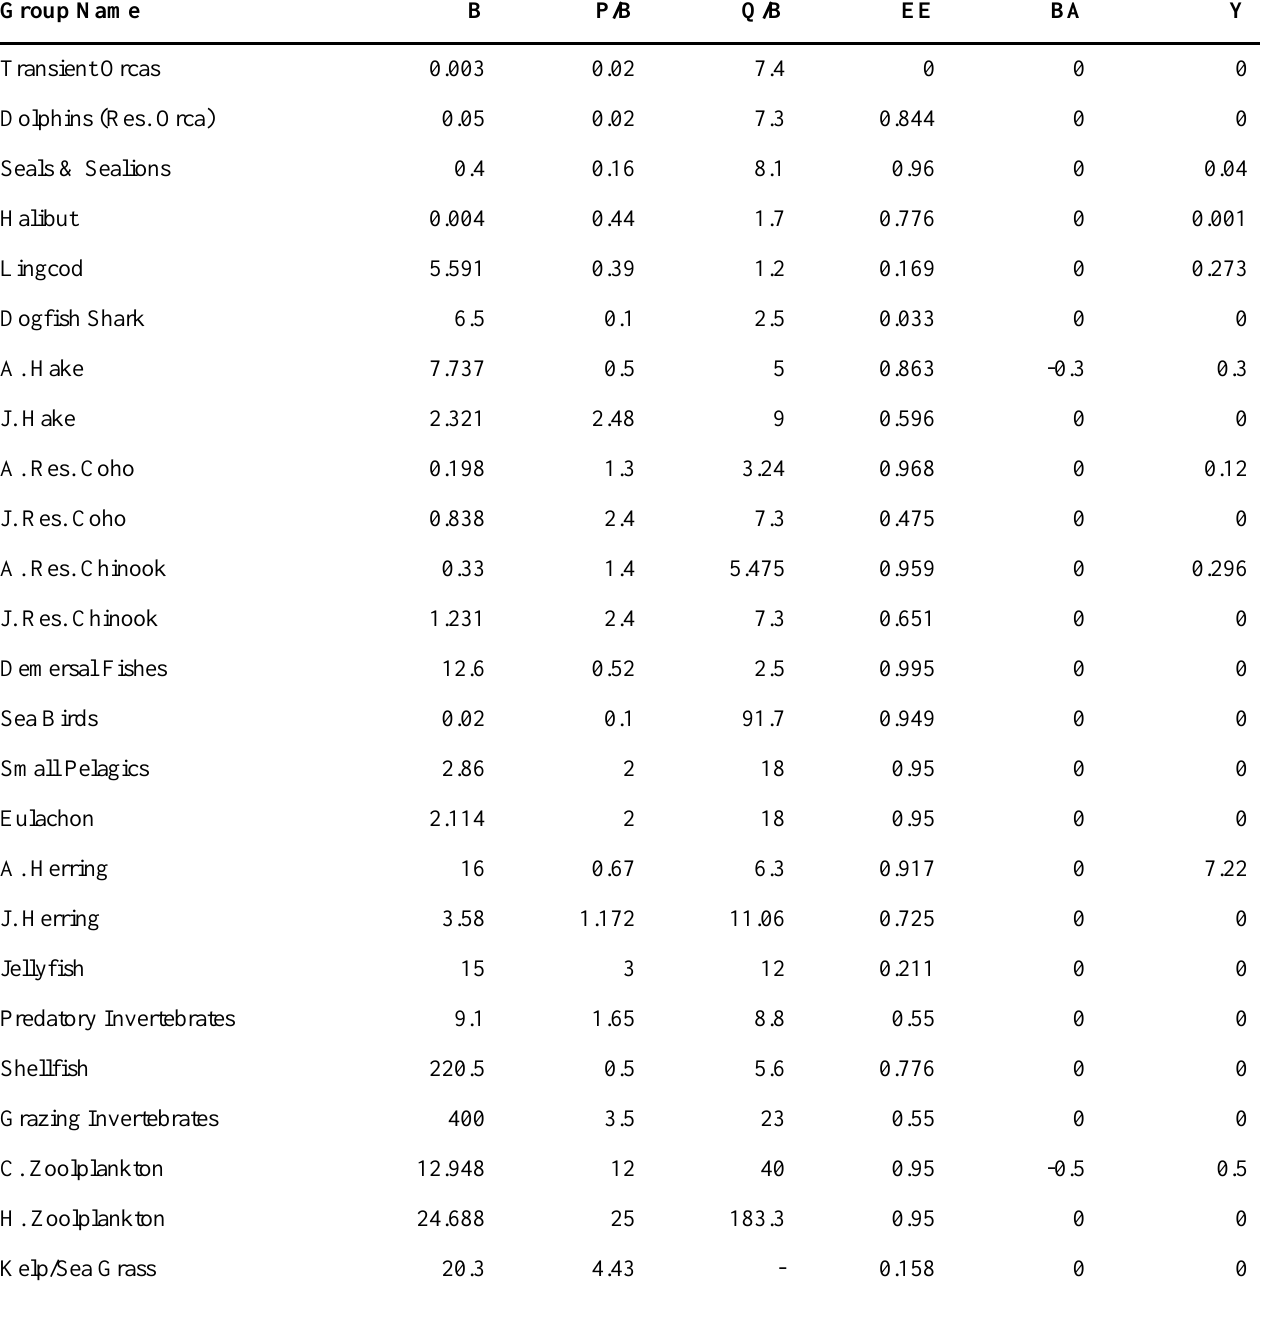
Table 2. Input parameters for 1950 SOG Ecopath model: B = biomass (t/km 2 ), P/B = production biomass ratio (year¡1), Q/B = consumption biomass ratio (year¡1), EE= fraction of P/B explained by fisheries and trophic interactions, BA = biomass accumulation (t km-2 year-1), and Y = landings from fisheries (t km-2 year-1). Bold values represent estimate parameters, and -BA = Y for fisheries that start after